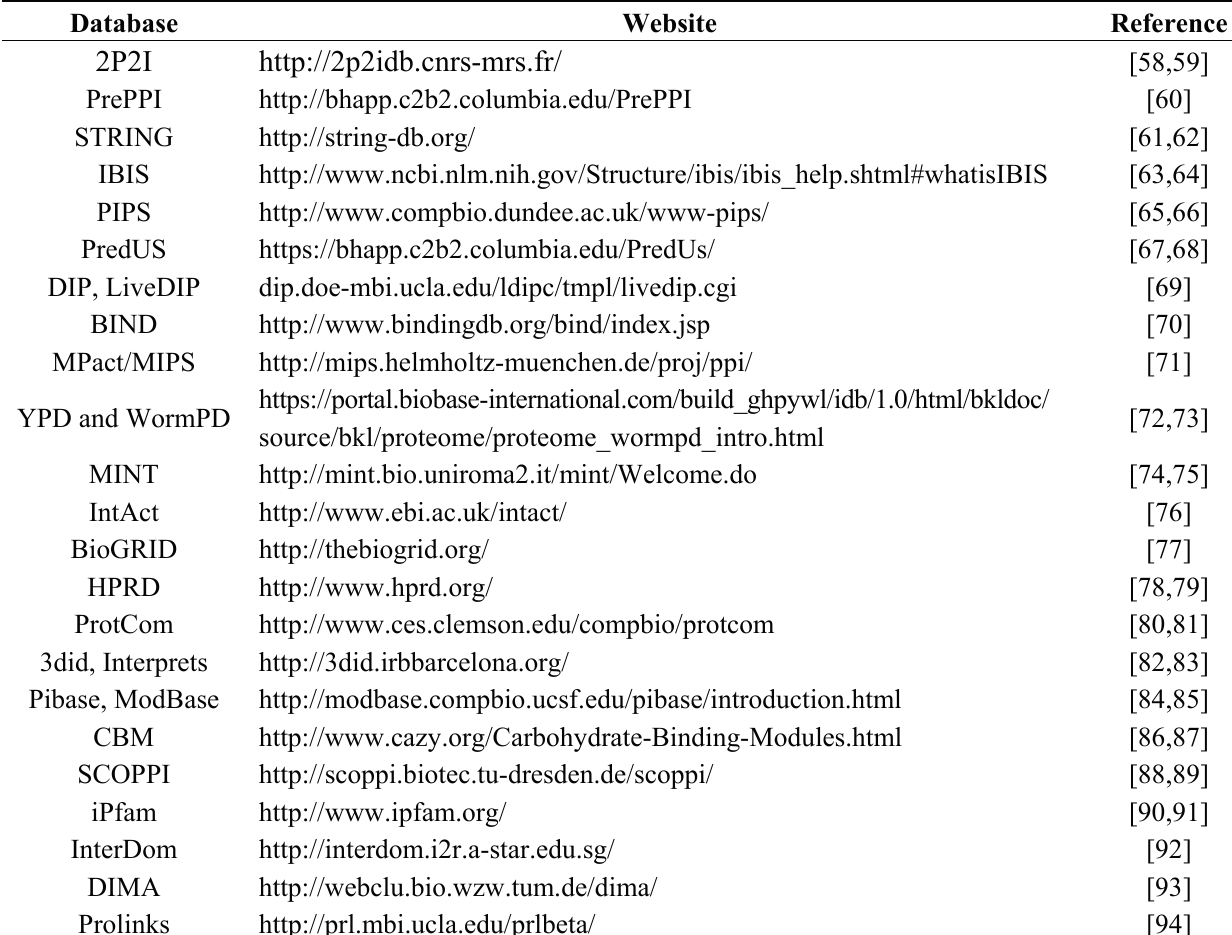
Table 1. List of protein-protein interaction databases and